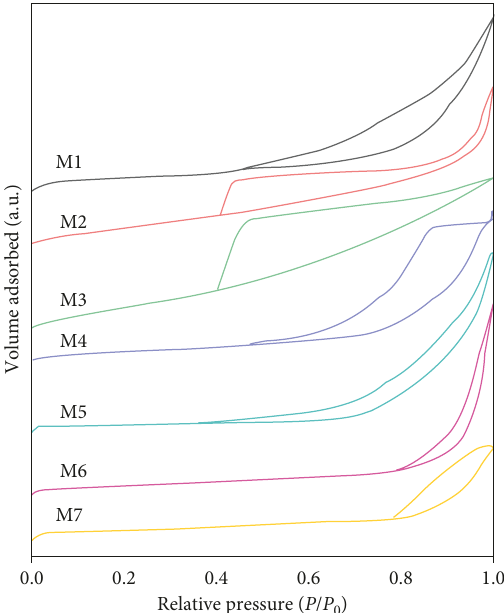
Figure 6: N 2 adsorption-desorption isotherms of activated hydrotalcites before photodegradation. Table 2: Textural properties of activated hydrotalcites.